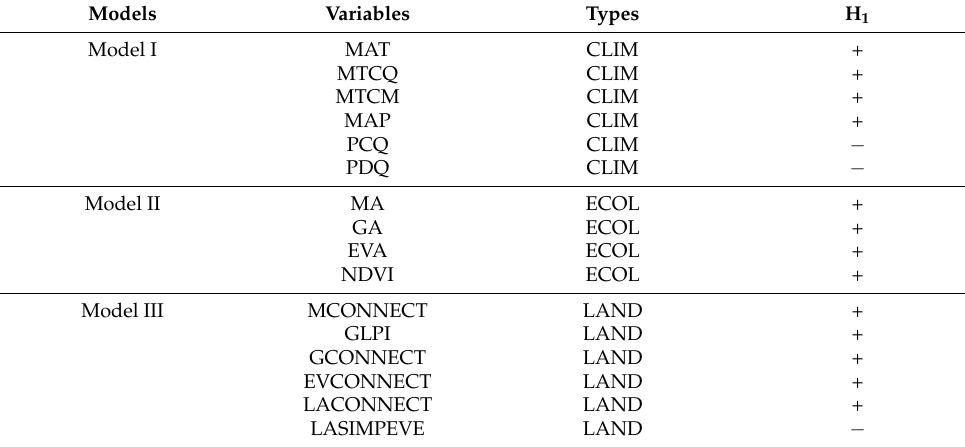
Table 2. Working hypotheses to test the effect of different variables on population trends of the Greater White-Fronted Goose ( Anser albifrons ) at the Shengjin Lake National Reserve between 1996 and 2019. The number of variables was reduced to avoid multicollinearity. H 1 indicated the predicted effect. + = positive effect, − = negative effect. For variable abbreviations, see Table